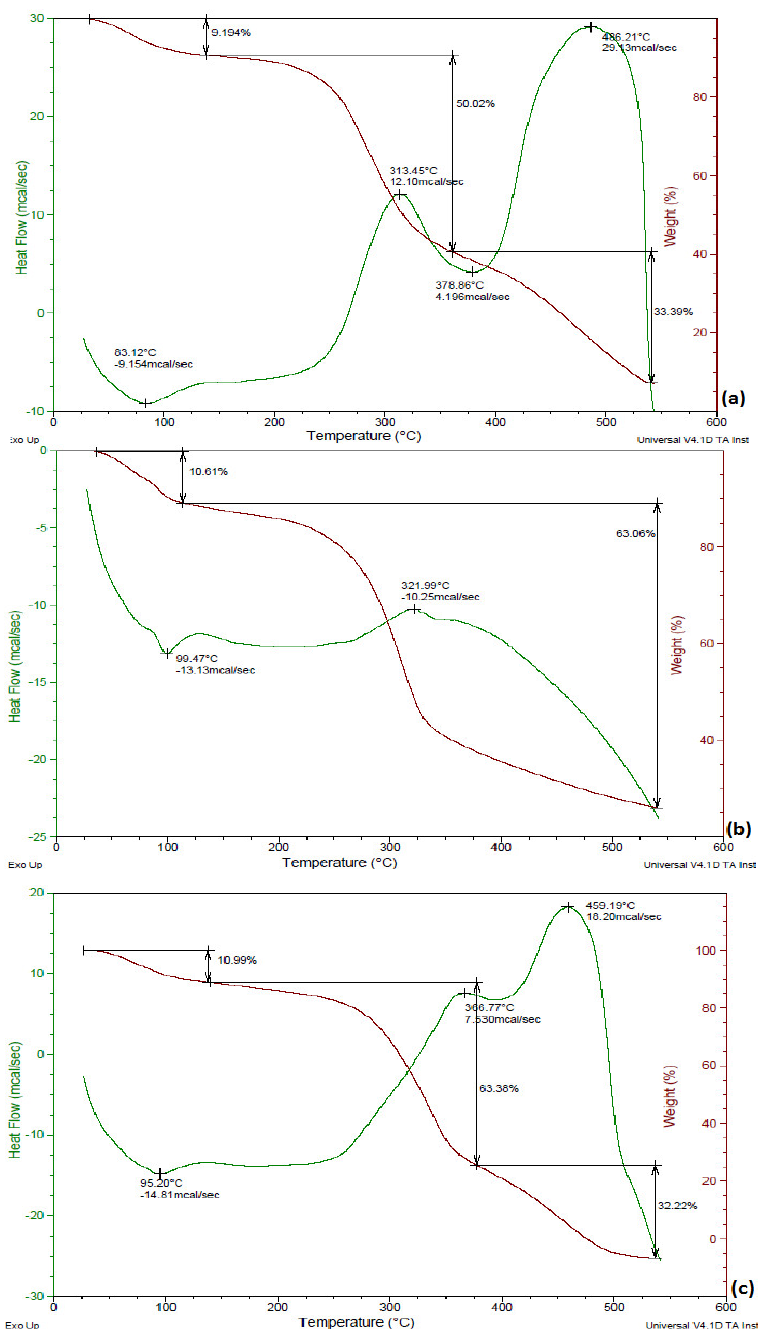
Figure 3. TGA of B. ceiba : ( a ) untreated, ( b ) KOH-treated, ( c ) KOH-steam-treated.